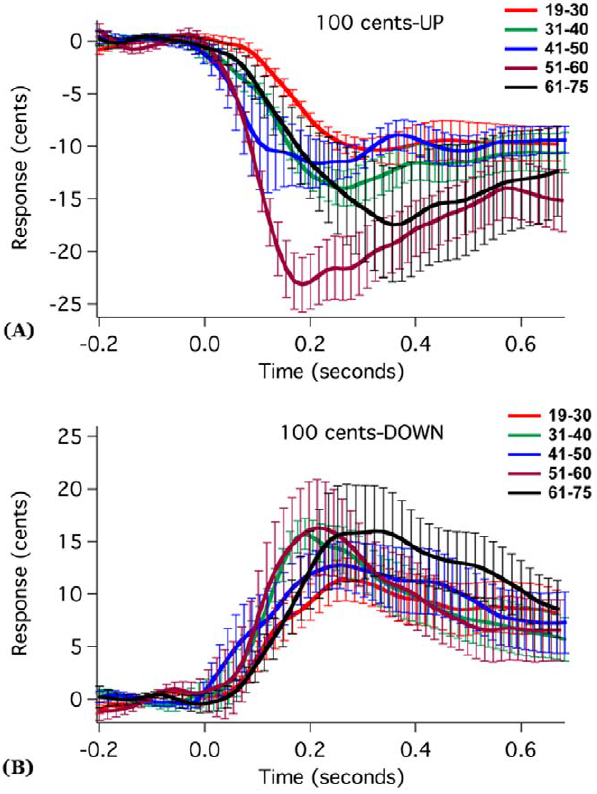
Figure 2. Grand averaged vocal responses over all subjects to upward (A) and downward (B) 50 cents pitch-shifted stimuli as a function of age. Solid lines represent average F 0 contour and vertical bars represent the standard errors of averaged traces.